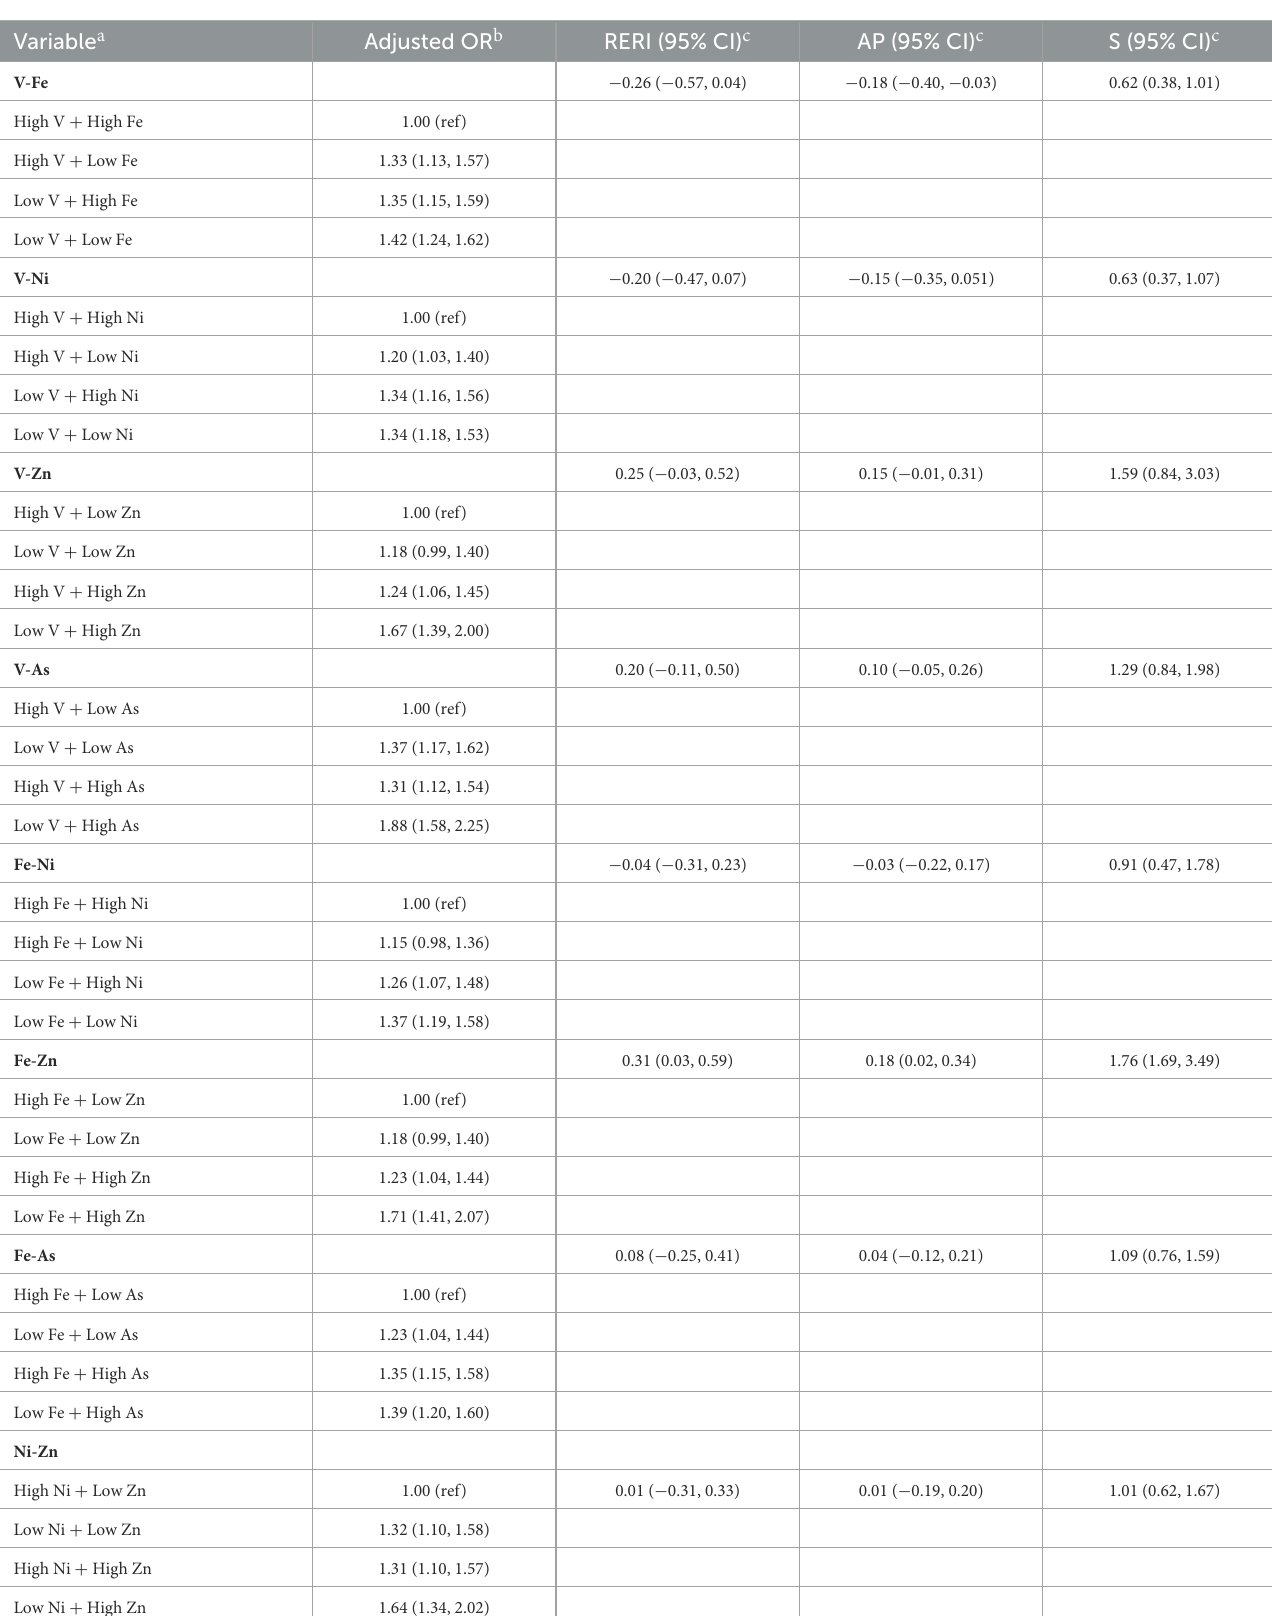
TABLE 3 Combined associations of urinary metals with hyperuricemia risk (OR, 95% CI). Variable